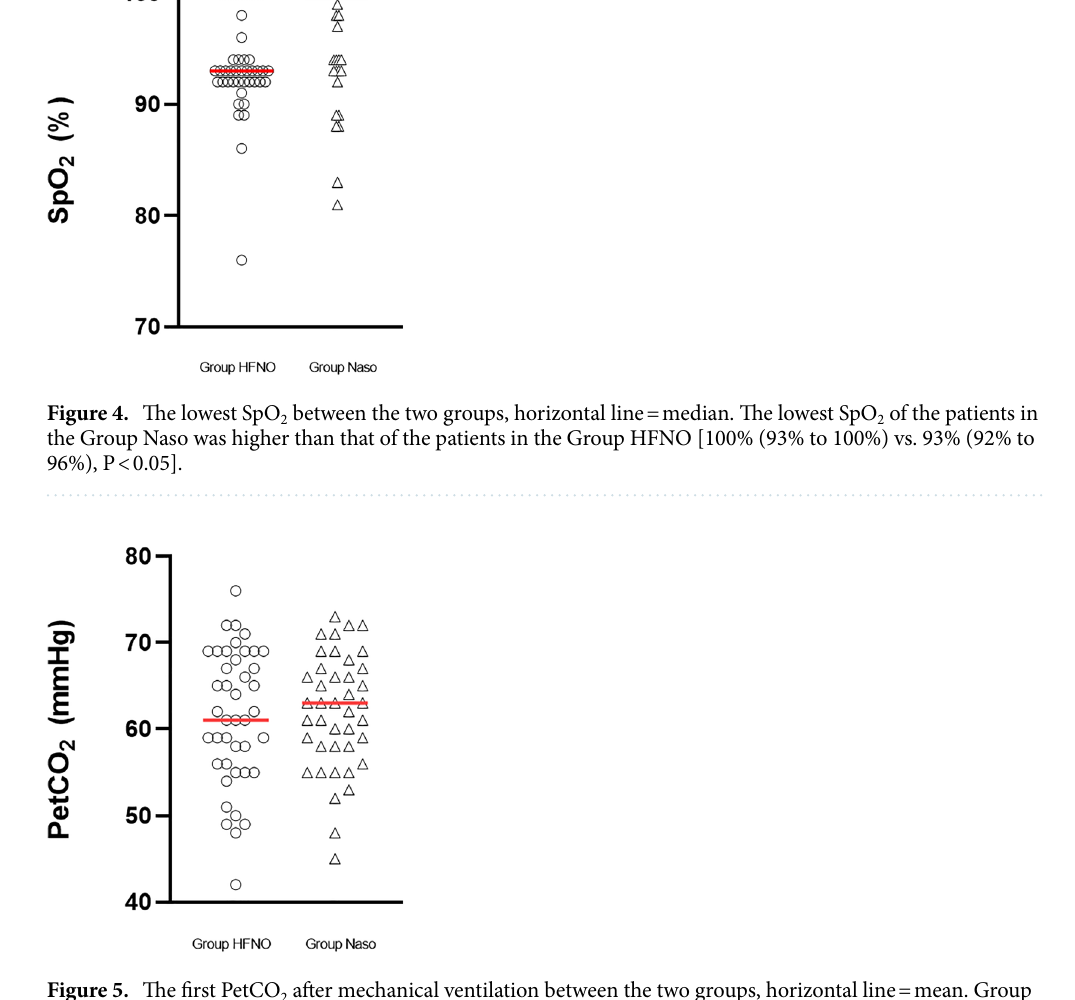
Figure 5. The first PetCO 2 after mechanical ventilation between the two groups, horizontal line = mean. Group Naso was higher than that in the Group HFNO(60.9 ± 8.5 vs. 62.0 ± 6.6 mmHg, P <